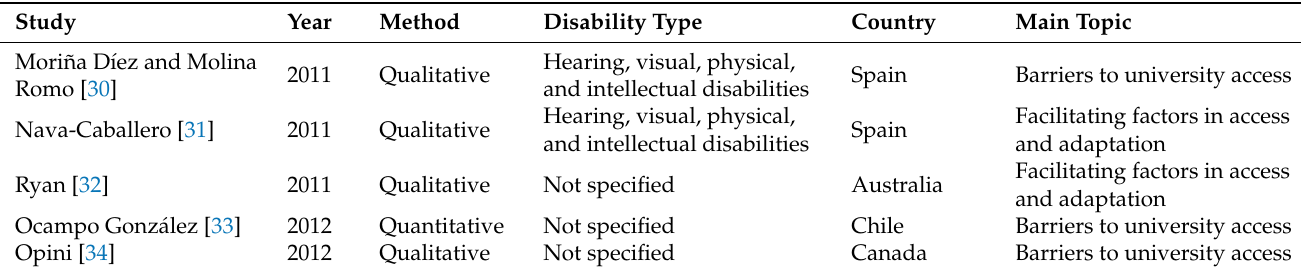
Table 1. Description of the studies included in the